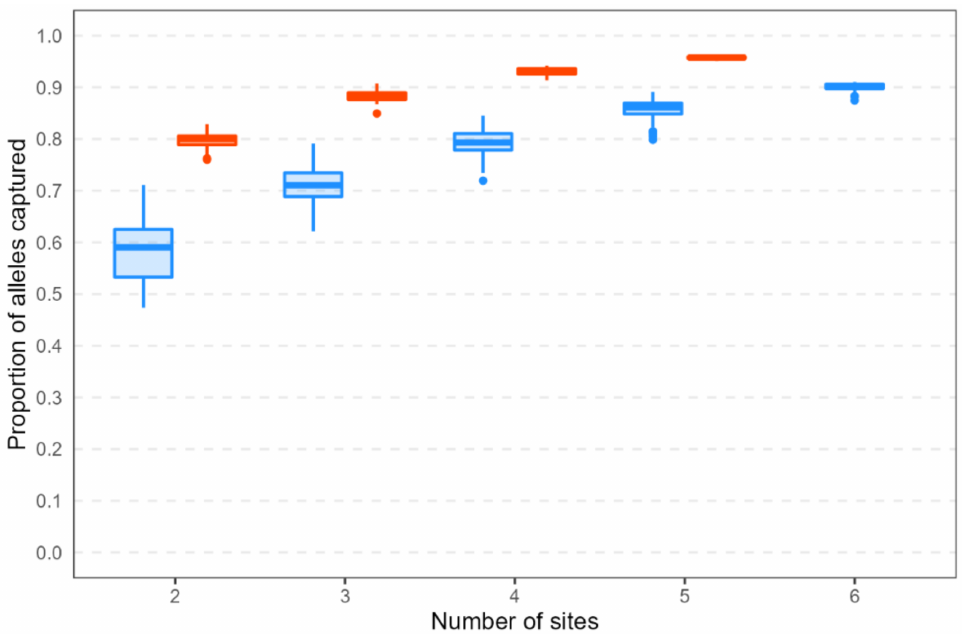
Figure 6. Proportions of alleles captured in seedling resampling replicates, out of all alleles found at ≥ 5% frequency in adult plants (i.e., including landscape-scale sampling sites from which no progeny were genotyped). Shown are results from 100 resampling replicates for 8 seedlings per site representing 8 maternal lines per site across increasing numbers of collection